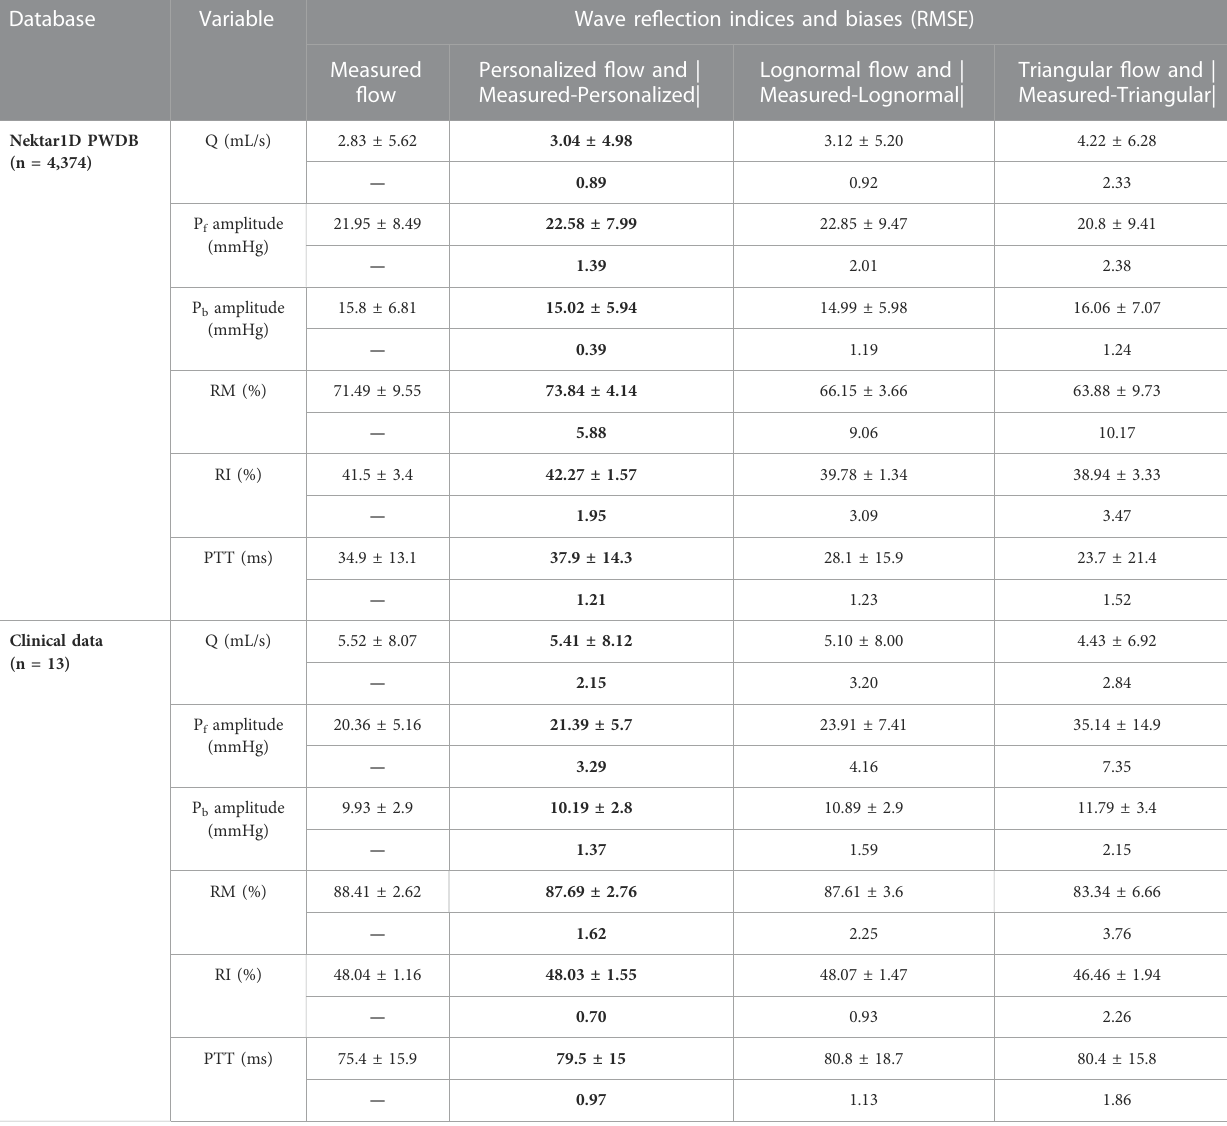
The bold values in Table 2 are the wave re fl ection indices results of the personalized fl ow wave, which have the smallest biases with the measured fl ow